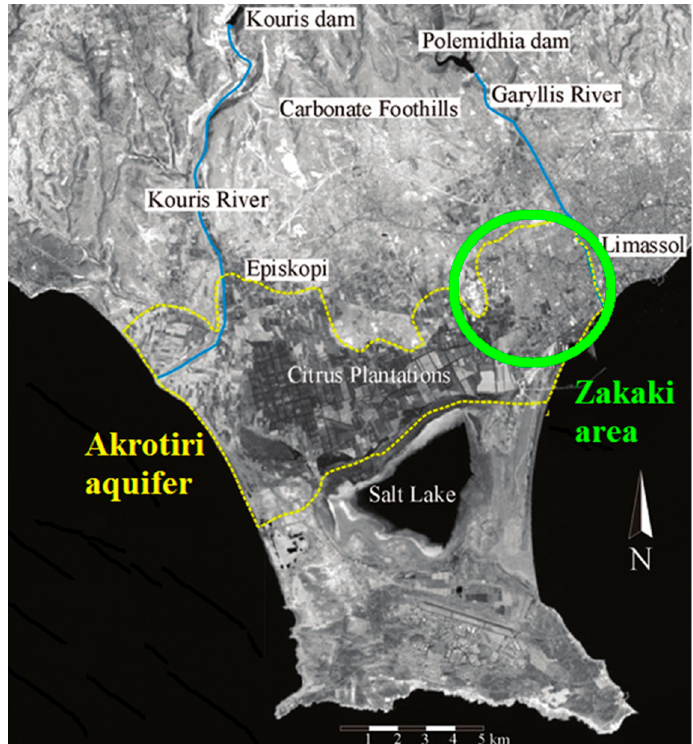
Figure A1. Map of the Akrotiri coastal aquifer, Zakaki area, Cyprus [52].